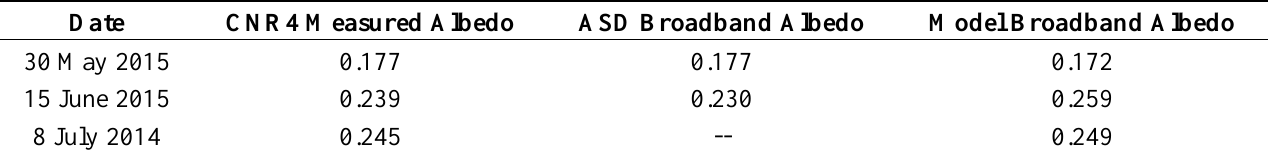
Table 3. Comparison between the broadband albedo directly measured using the CNR4 from the Analytical Spectral Devices (ASD)-measured and model-simulated spectral